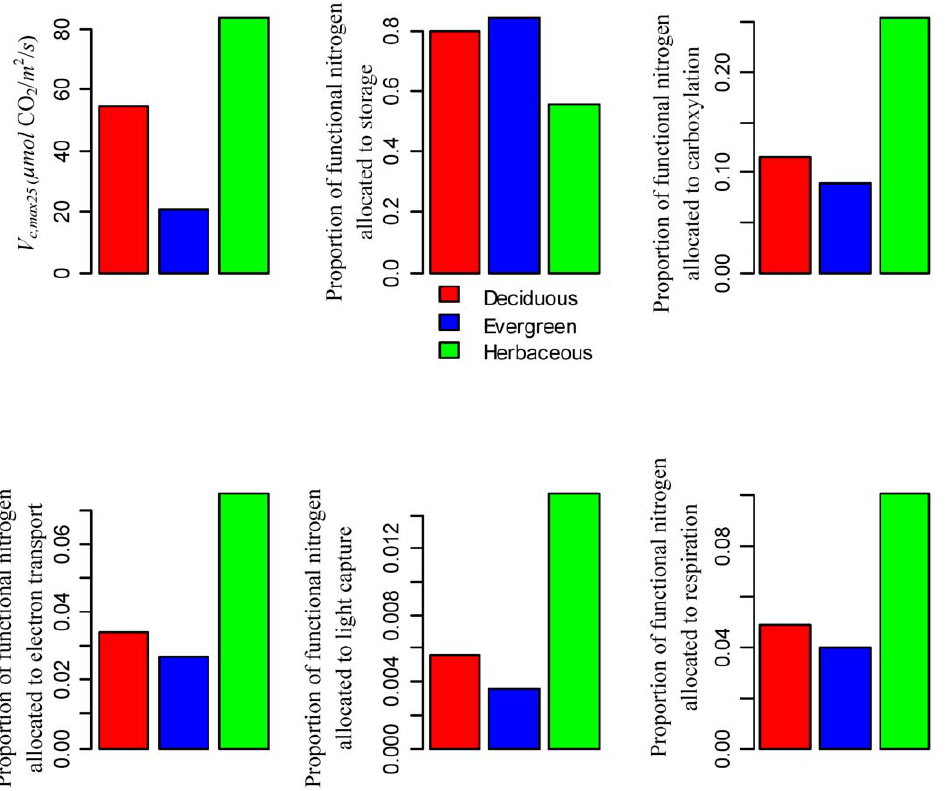
Figure 2. V c,max25 ( V c,max scaled to 25 6 C) and nitrogen allocation coefficients for deciduous trees, evergreen trees, and herbaceous plants for the control case (temperature=15 6 C; radiation=800 m mol photon/ m 2 / s ; CO 2 =370 ppm ) in the sensitivity analysis. The nitrogen allocation coefficients are estimated with the nitrogen allocation model using parameter inputs from Table 3.